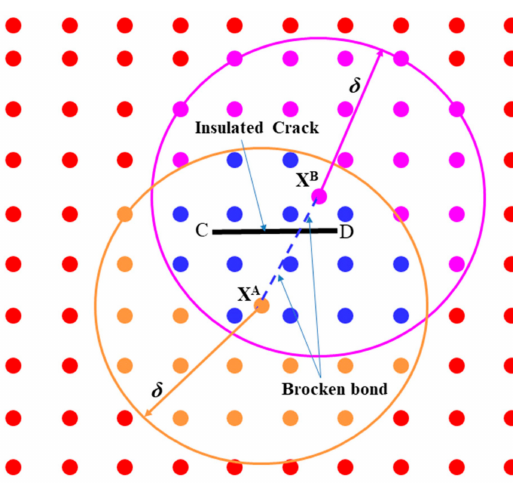
Figure 2. Breakage of bond between nodal points X A and X B that intersect an insulated crack